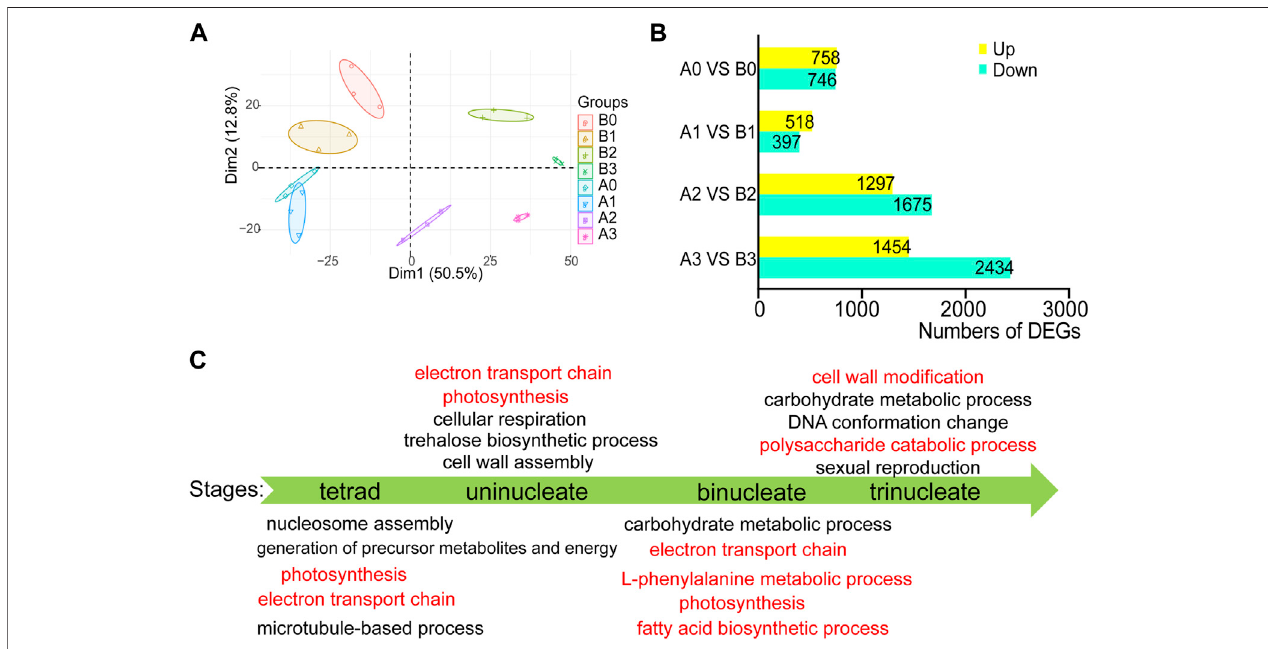
FIGURE 1 | Differentially expressed genes and GO function analysis in AL18A at different developmental stages. (A) Principal component analysis (PCA) of RNA- seq datafor fourstages ofwheat anther development. B0,B1, B2,and B3representthetetrad, uni-nucleate, bi-nucleate and tri-nucleate stagesofanther development of AL18B; A0, A1, A2, and A3 represent the tetrad, uni-nucleate, bi-nucleate and tri-nucleate stages of anther development of AL18A, respectively. (B) The number of DEGs between AL18A and AL18B at different anther developmental stages. DEGs: differentially expressed genes. (C) GO function enrichment analysis of DEGs between AL18A and AL18B at different anther development stages.